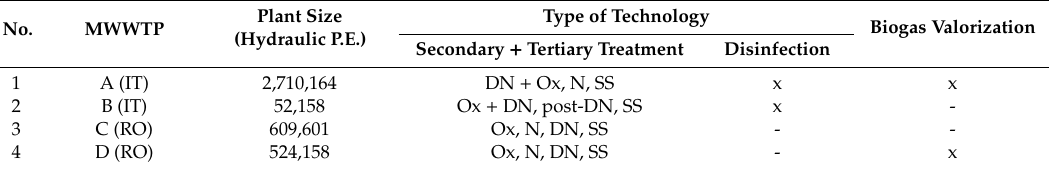
Table 2. Process outlines of the considered case studies (Ox, biological oxidation, N, nitrification, DN, denitrification, SS, secondary sedimentation; P.E., population equivalents).